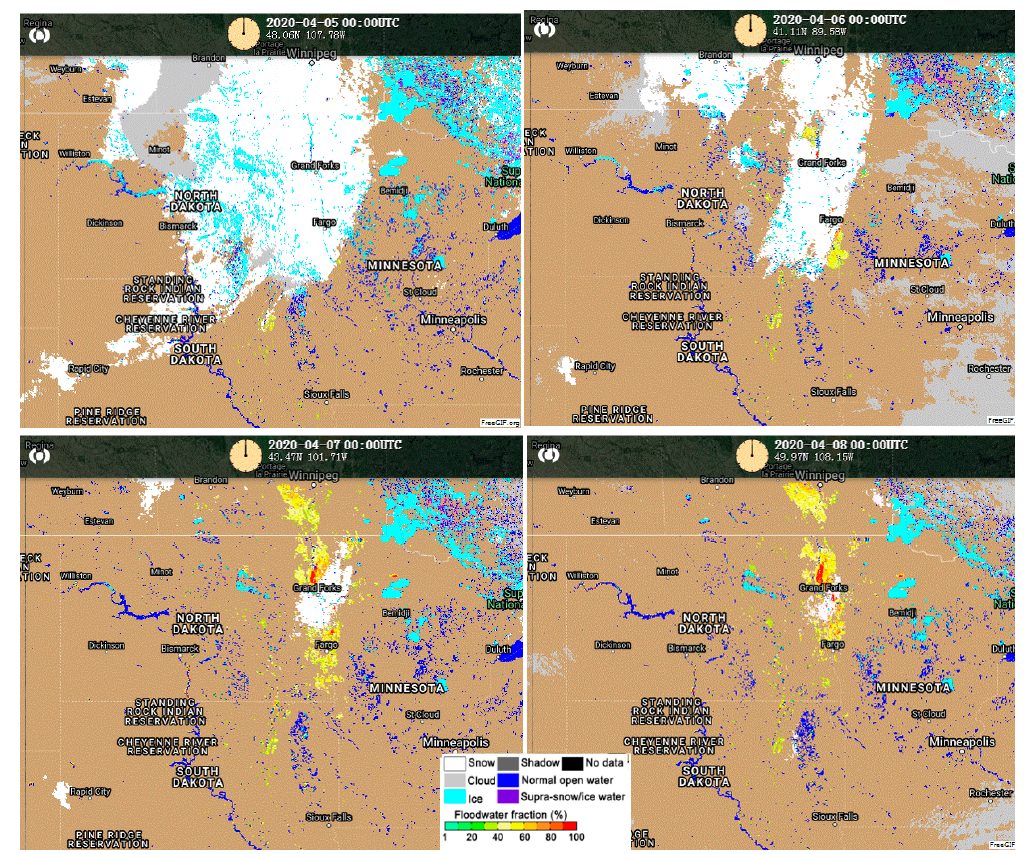
Figure 5. GOES-R ABI Flood Extent Product on April 5 ( a ), 6 ( b ), 7 ( c ) and 8 ( d ), 2020.